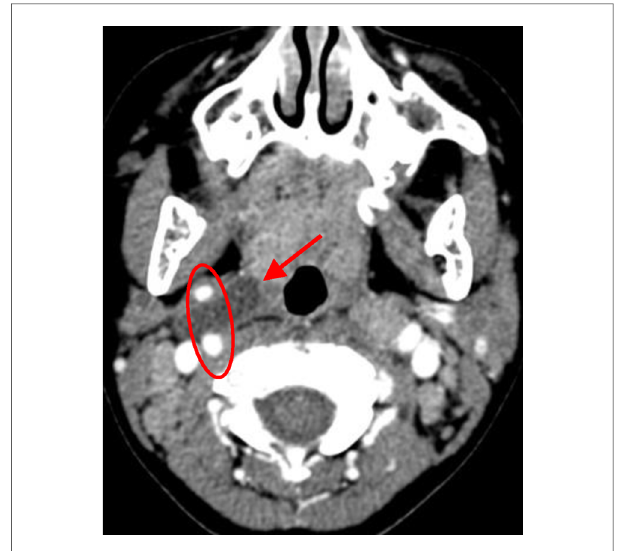
FIGURE 3 The Bailey type III. The lesion (red arrow) extended medially between the bifurcation of internal and external carotid arteries (circle) to the lateral pharyngeal wall.